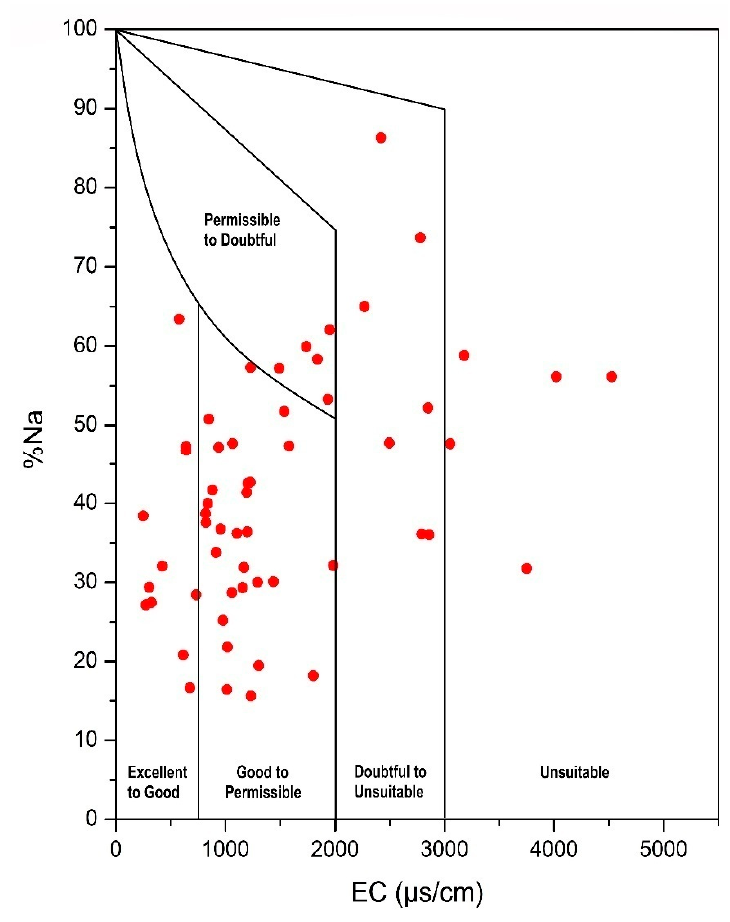
Figure 11. Plot of percentage sodium (%Na) versus EC (Wilcox 1948).